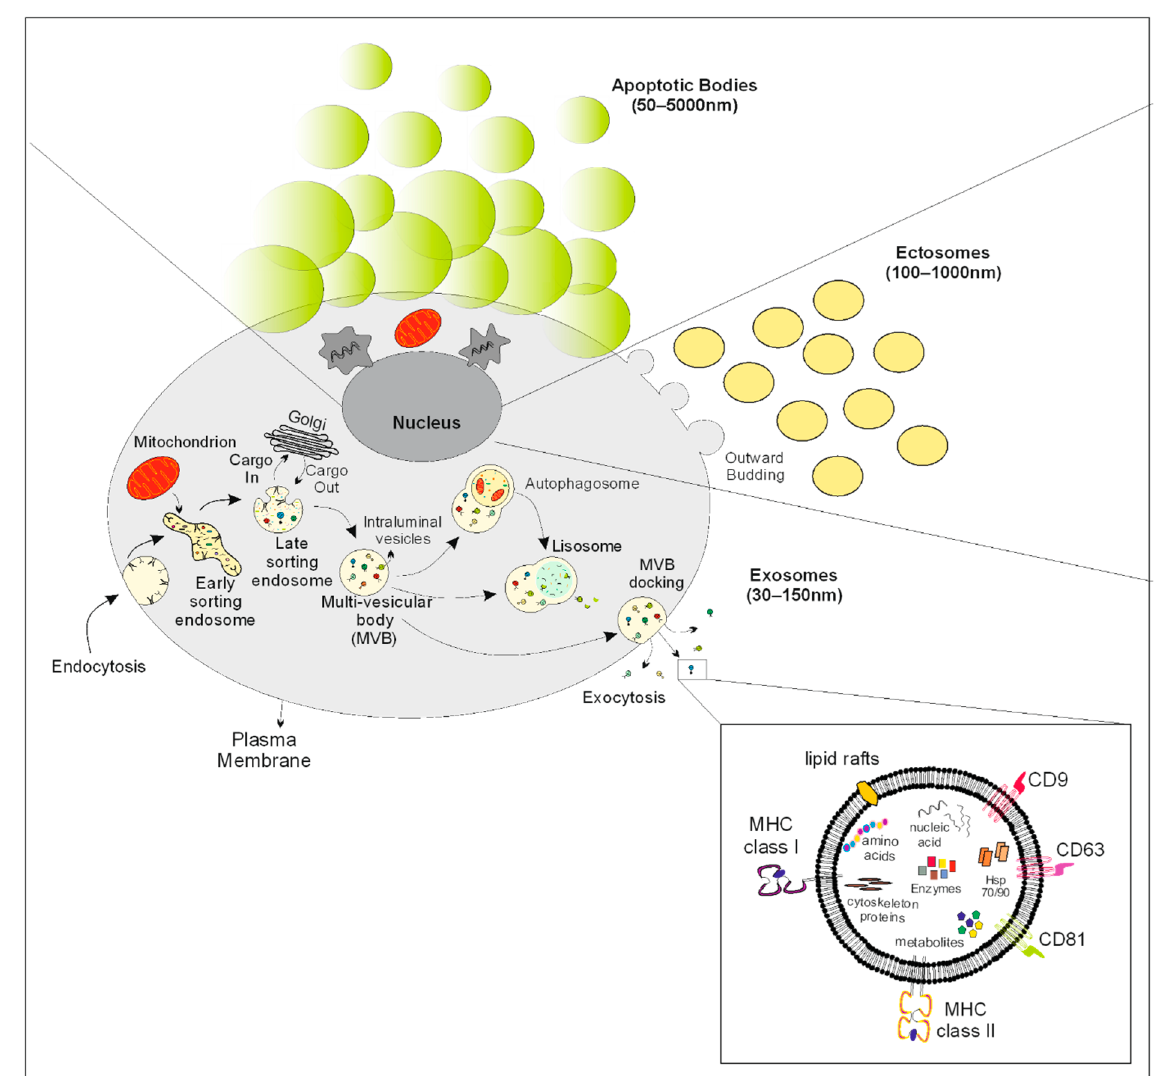
Figure 1. The figure illustrates the biogenesis, size and main features of the different classes of EVs. The EV cargo is equally variable and may include proteins, lipids, RNAs (miRNA, lcg–RNA) and DNA. This cargo differs depending on its cellular source, reflecting that of the parental cell. More interestingly, EVs have the unique ability to transfer their content to target cells, modifying the biological properties of the recipient cell. This is mediated either by: (i) contact, referring to receptor–ligand interaction; (ii) uptake, referring to internalisation of the EVs; (iii) fusion, referring to fusion of EVs with the plasma membrane; or (iv) a combination of the above [6].